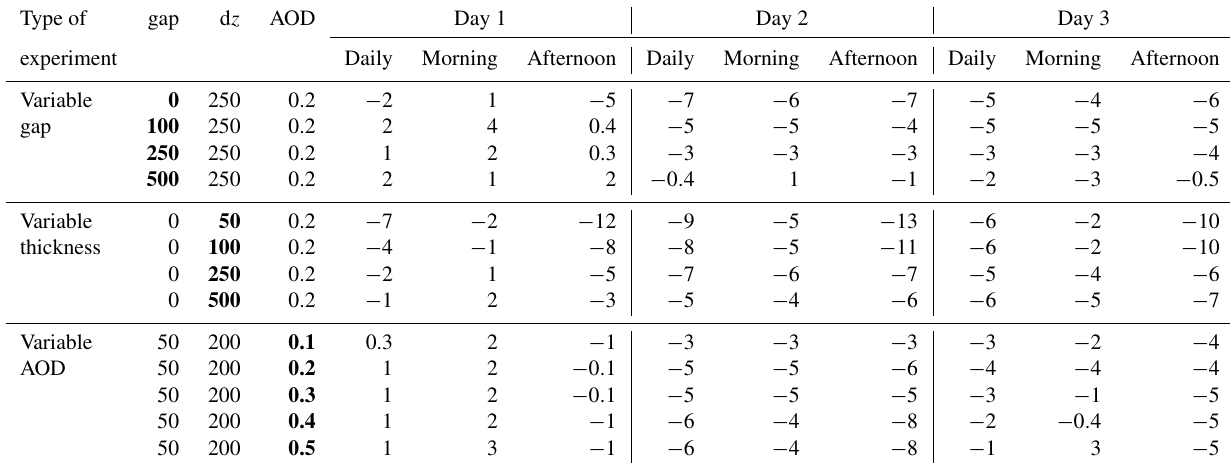
Table 3. Mean semi-direct effect (Wm − 2 ) for each of the aerosol experiments shown in Fig. 2 and Table 2. Mean values are presented for each day (daily) between 00:00 and 12:00 (morning) and between 12:00 and 24:00 (afternoon). Bold text emphasizes the variable that is being tested in each set of